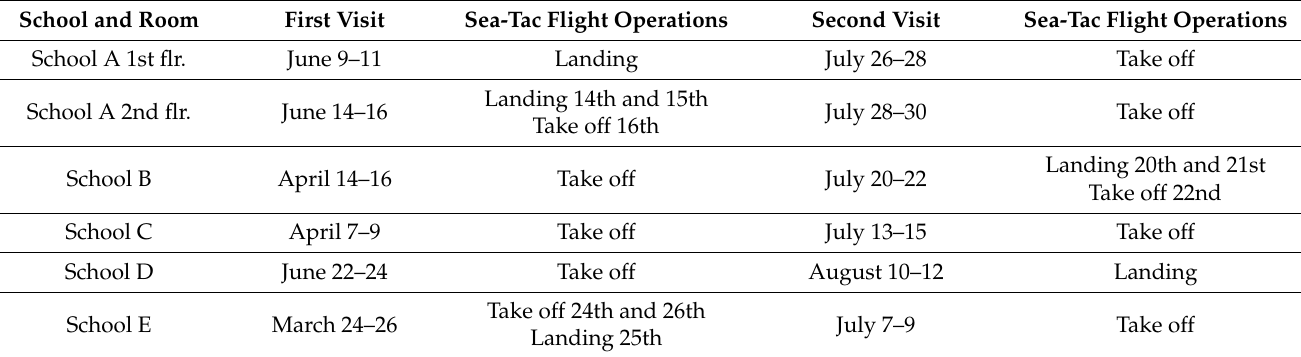
Table 3. School classroom visit dates and aircraft operations at school